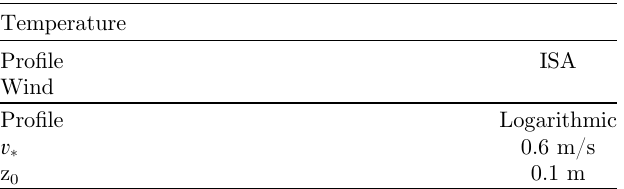
Table 1. Settings for atmospheric pro fi les used throughout this